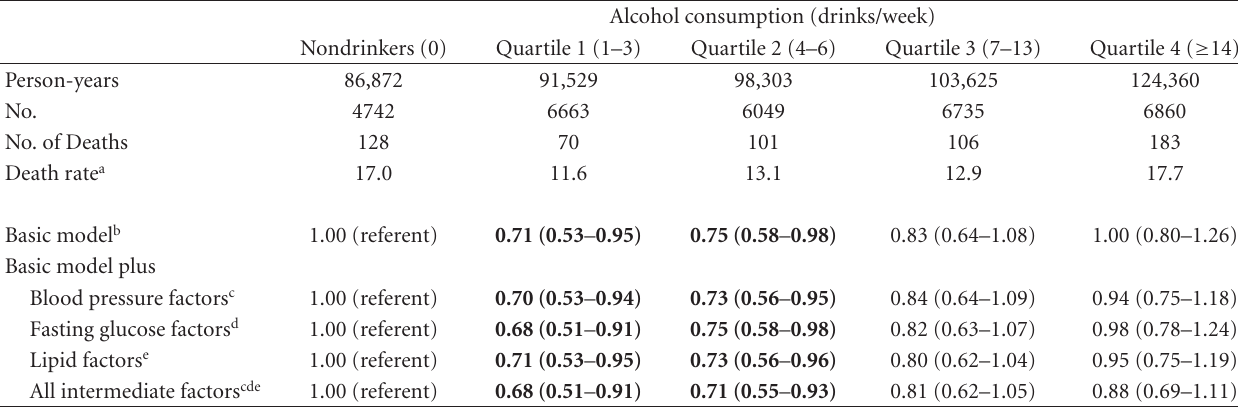
Table 3: Hazard ratios of CVD mortality by alcohol consumption level in men, Aerobics Center for Longitudinal Study (ACLS), 1974–2002.